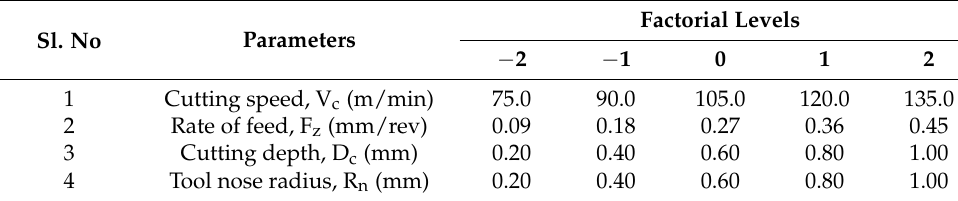
Table 2. The factorial levels of output process parameters.